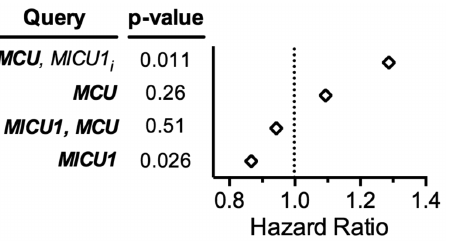
Figure 1. Expression of mitochondrial Ca 2 + uniporter subunits is associated with breast cancer patient survival. Hazard ratios of queried gene expression combinations from the BreastMark mRNA survival analysis online algorithm. Patient survival was correlated to sample gene expression after genes were queried alone or in combination for overexpression ( bold ) and inverse underexpression ( not bold i ) and represented as hazard ratios. See Table S1 for more details including sample number, p-values, and queries for expression relationships for other uniporter subunit genes.